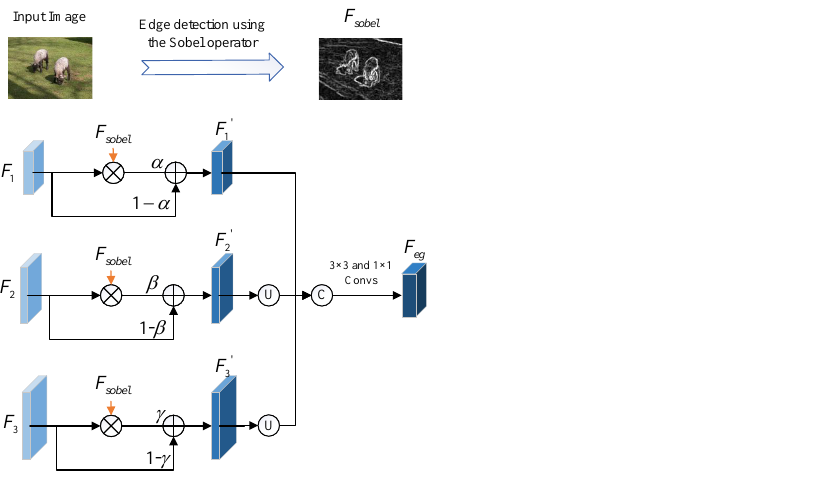
Figure 4. The visual illustration of the EAS module, which receives three shallow ResNet-50 features of the query image, and uses the Sobel operator to generate the edge guidance feature.